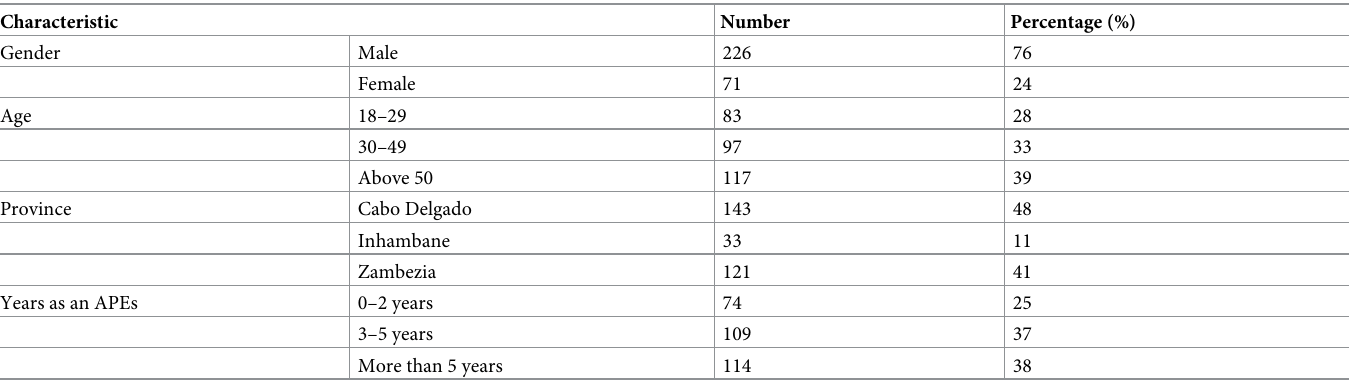
Table 1. Demographic characteristics of respondents (N = 297).